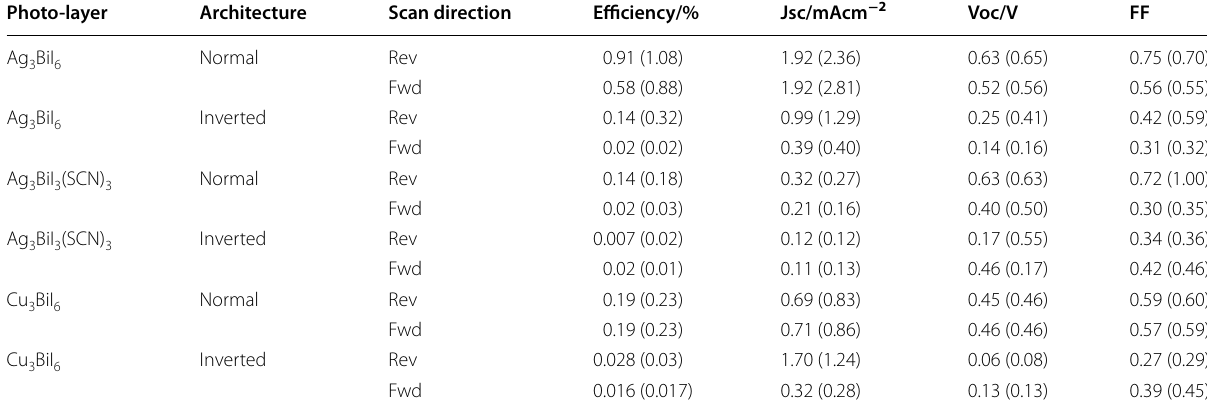
Data shown here represent the average of three independent solar cell parameters. Best representative photovoltaic parameters are shown in the